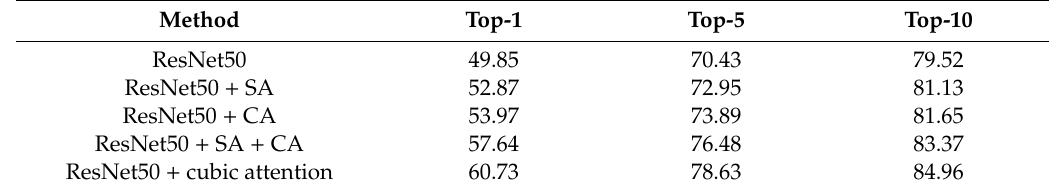
Table 2. Cubic attention mechanism e ff ectiveness experimental results.